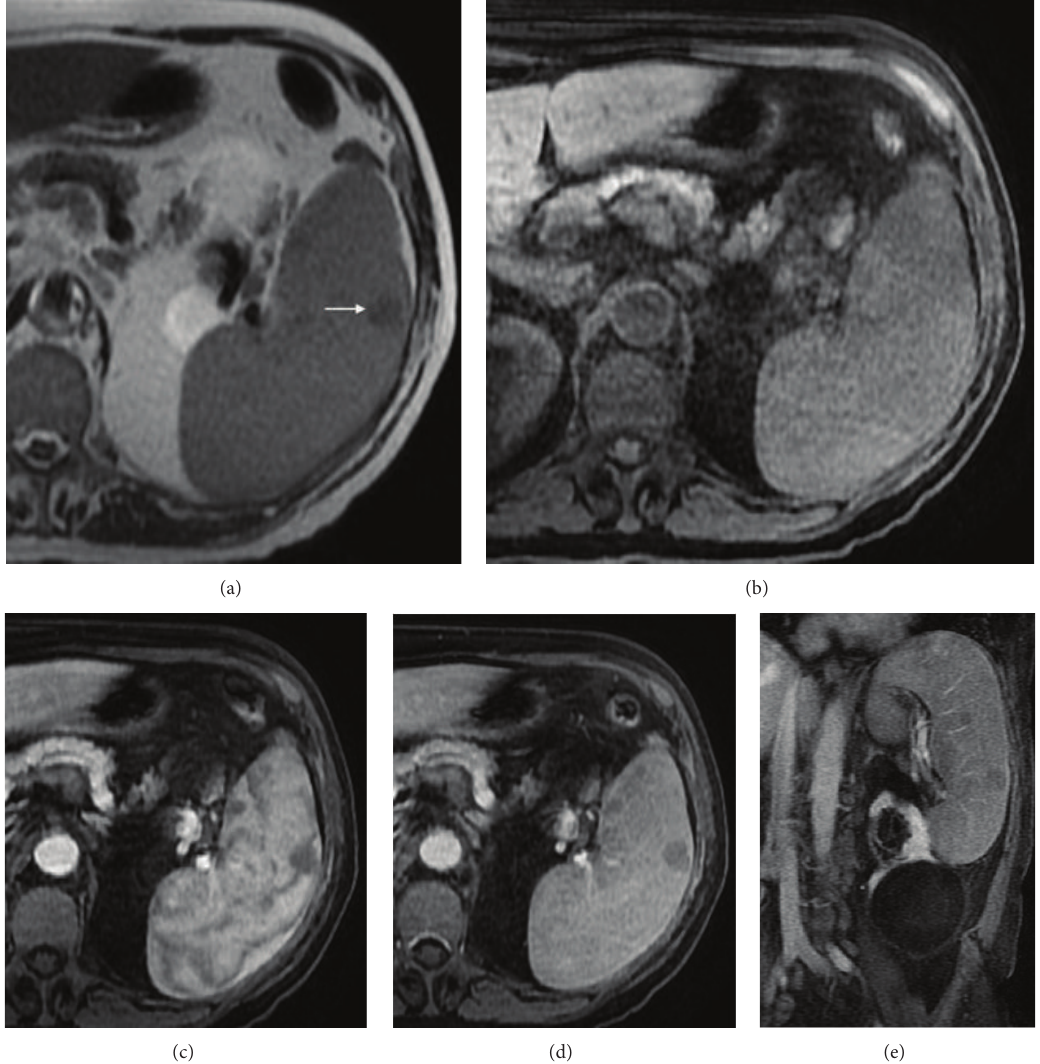
Figure 16: Lymphoma. Axial T2wi SSFSE (a), axial pre- (b) and postcontrast T1wi 3D-GRE with fat suppression in the arterial (c) and venous (d) phase. Coronal fat-suppressed T1wi 3D-GRE in the interstitial phase (e). The spleen is enlarged. Lymphomatous nodules are isointense to splenic parenchyma on T1wi (b) and T2wi (a). One nodule is moderately hypointense T2wi (arrow, (a)). This feature aids in distinction against metastatic lesions, which are commonly hyperintense. Lymphomatous lesions demonstrate hypovascular nature with lower signal intensity relative to normal spleen on postcontrast images ((c), (d) (e)), thereby increasing